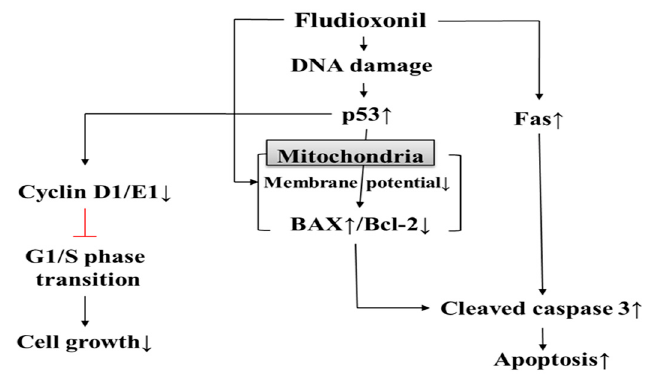
Figure 8. Cytotoxicity of fludioxonil on human immune cells. Fludioxonil leads to apoptosis that is mediated by the mitochondria and death receptor ( Fas ). In mitochondria, fludioxonil depolarizes membrane potential and increases expression of p53, then p53 alters the expression of BAX and Bcl-2. Increased BAX activates cleaved caspase-3. Fludioxonil increases gene expression of Fas, which activates cleaved caspase-3. Activated cleaved caspase-3 induces apoptosis. Additionally, fludioxonil decreases the expression of cell cycle-related genes, such as cyclin D1 and E1, and decreased cyclin induces cell cycle arrest.